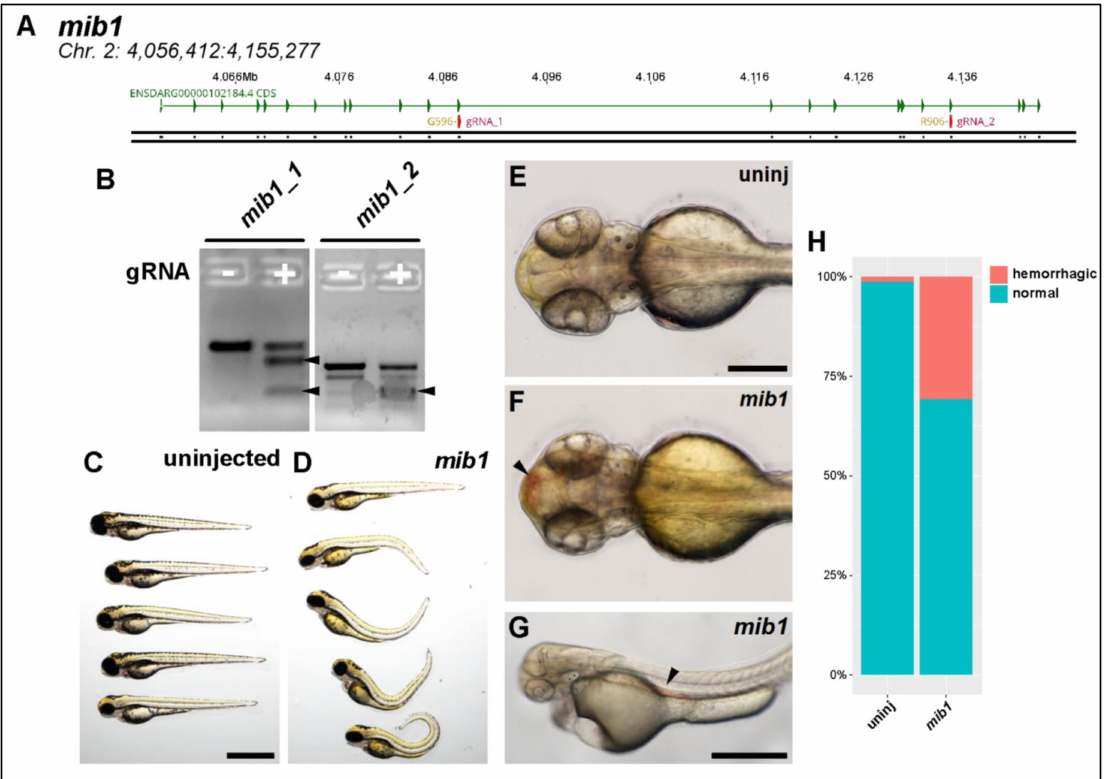
Figure 4. Knocking out mib1 generates a hemorrhagic phenotype. ( A ) Genomic region of chromosome 2 containing mib1 gene. Two patient mutations G596 and R906 are indicated. gRNAs (magenta) were designed to target both regions. ( B ) T7 endonuclease activity against gRNA target amplicons. Uninjected DNA pool ( − ) produces one fragmentation pattern, mib1- injected DNA pool (+) produces extra bands (filled arrowheads) caused by heteroduplex DNA formation due to editing and subse- quent digestion by T7 endonuclease. ( C ) Brightfield macroscopic image of representative series of uninjected larvae at 3 dpf. Scale bar: 1 mm. ( D ) Similar image of mib1 knockout fish. Note severe body curvature defects. ( E ) Uninjected 54 hpf fish, dorsal view. Scale bar: 250 µ m. ( F ) Similar mib1 knockout fish exhibiting cranial hemorrhage (filled arrowhead). ( G ) Brightfield image of 50 hpf mib1 knockout fish with aortic hemorrhage (filled arrowhead, scale bar: 500 µ m). ( H ) Quantification of hemorrhagic phenotype. Mib1 knockout fish exhibit significantly more hemorrhagic events (uninj: 1%, mib1 : 31%, chi-square test, p <